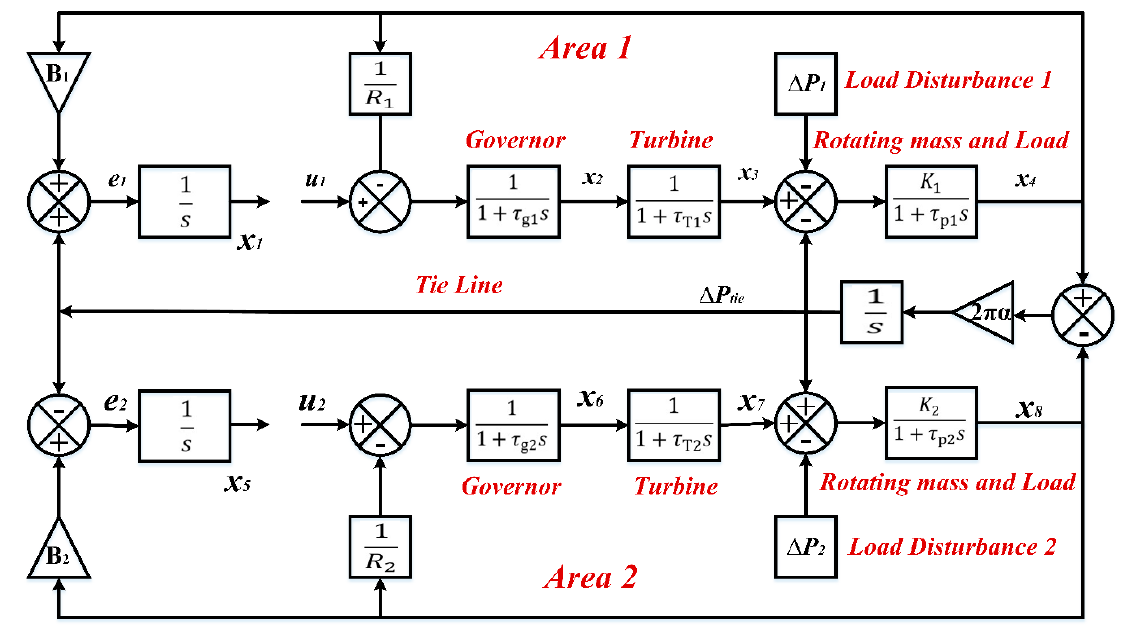
Figure 6. The block diagram of a two-area PSN based on a transfer function.